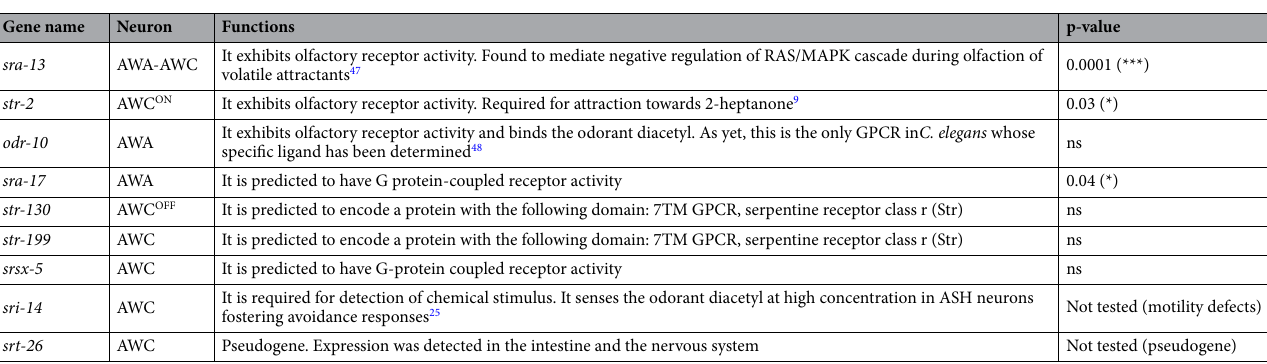
Table 2. Summary of GPCRs functions and result in the chemotaxis assays. Information on expression profile and function of each receptor was acquired from WormBase version WS273. Comparison between N2